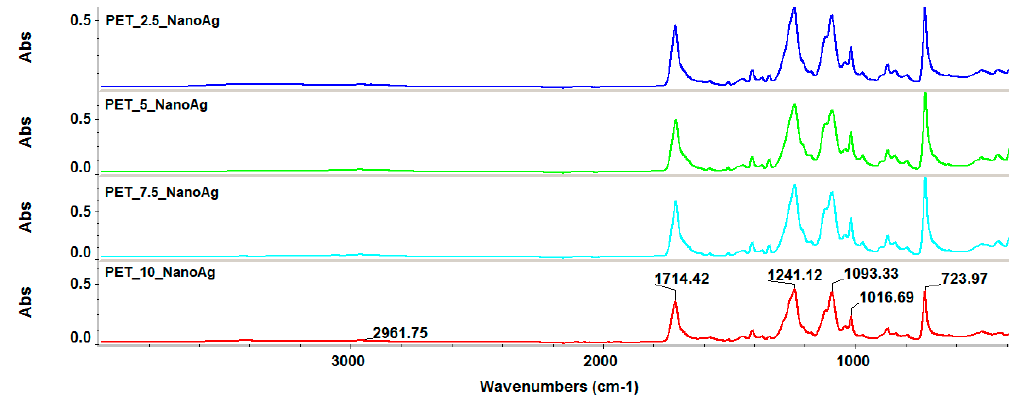
Figure 3. Fourier-transform infrared (FT-IR) spectra recorded for the silver-loaded polyethylene terephthalate (PET_X_NanoAg) samples.